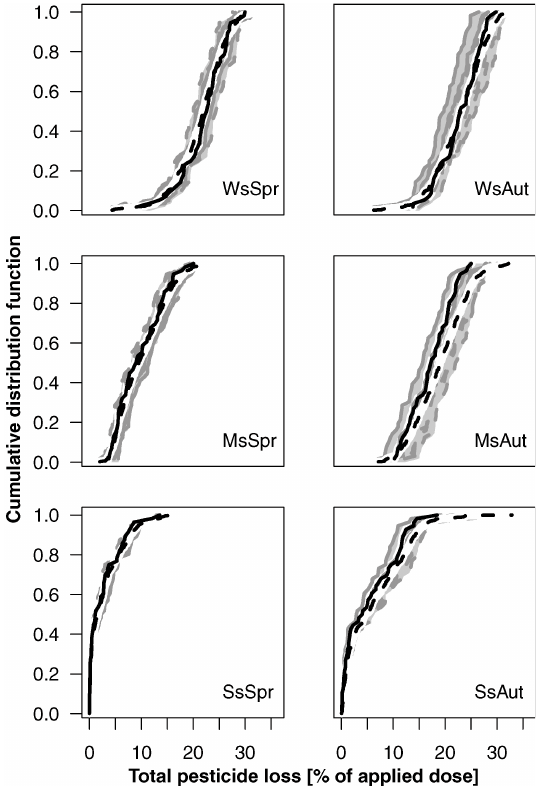
Fig. 4. Cumulative distribution functions of simulated pesticide losses for present (black solid) and future (grey lines) climate con- ditions based on nine different climate scenarios and 56 different parameterizations of the pesticide fate model. The aggregated en- semble predictions for the future are shown as black dashed lines for each of the pesticide application scenarios (abbreviations according to Table